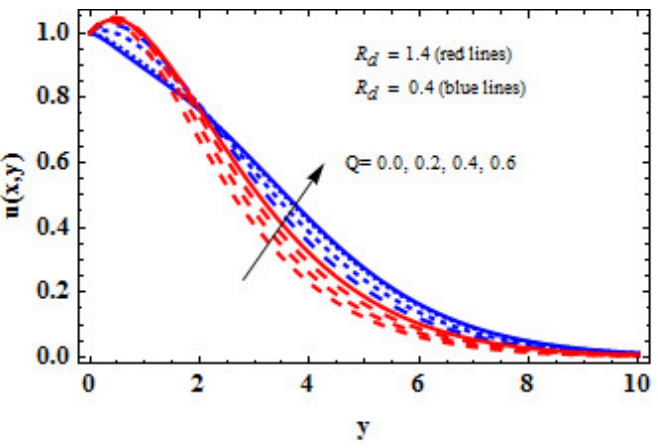
Figure 13. Q effect on concentration with respect to R